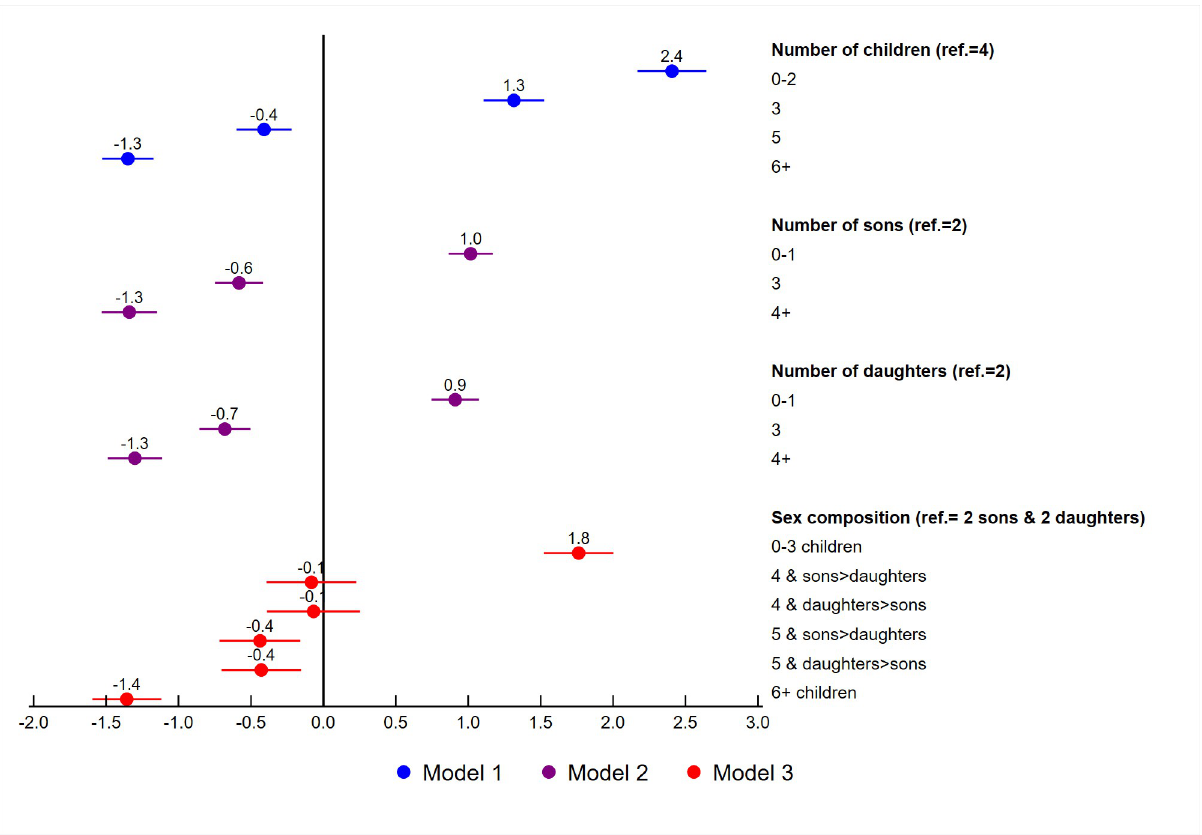
Fig 6. Adjusted regression coefficients for the fertility variables among women age 44–48, Eastern and Southern Africa.